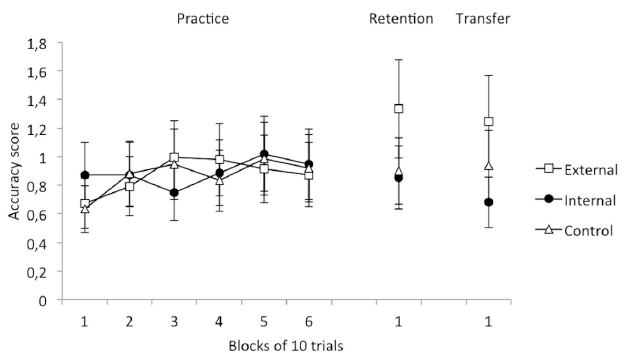
Figure 2. Accuracy scores of the external focus, internal focus, and control groups during practice, retention, and transfer. Note: Error bars represent standard